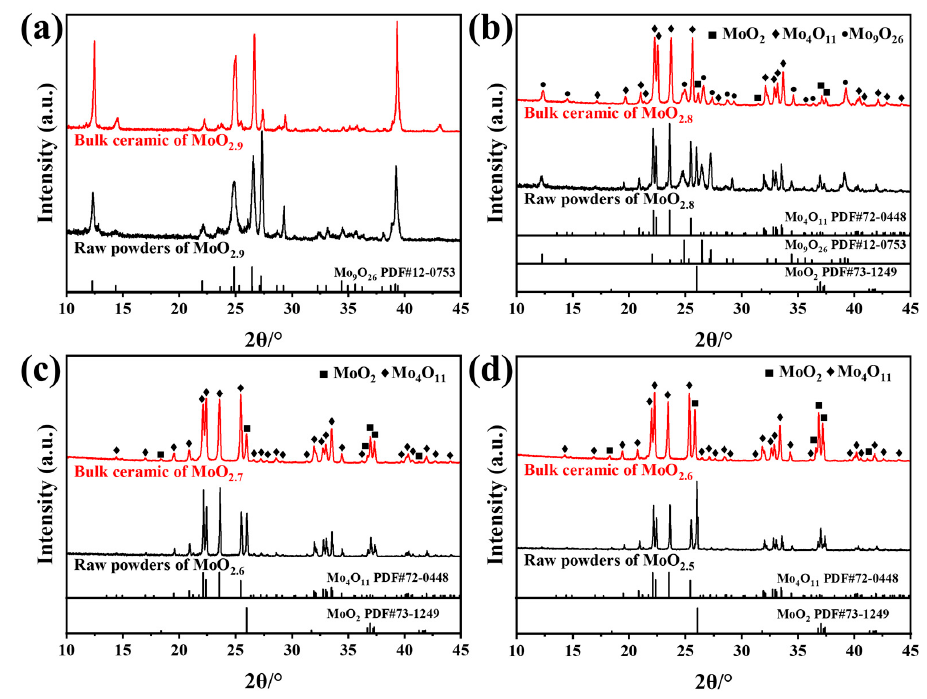
Figure 11. XRD patterns of A ( a ), B ( b ), C ( c ) and D ( d ) before and after Figure 11. XRD pa tt erns of A ( a ), B ( b ), C ( c ) and D ( d ) before and after sintering.